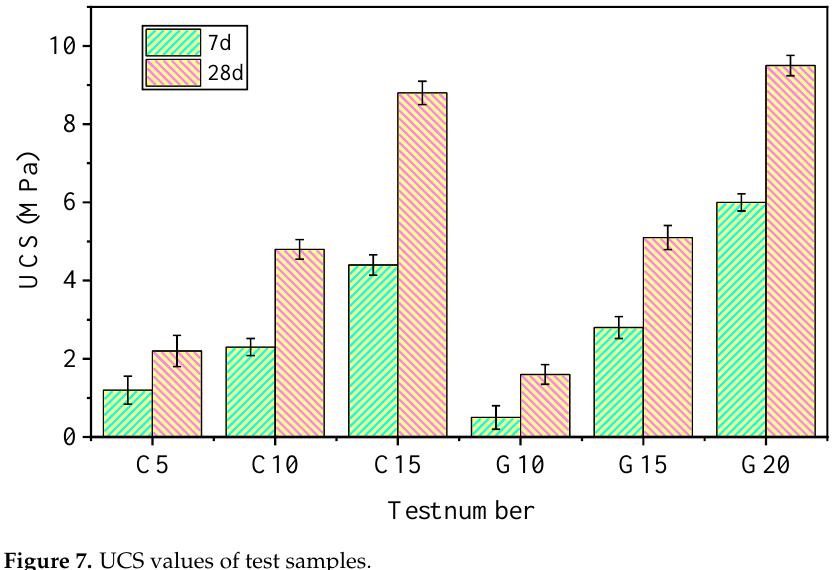
Figure 7. UCS values of test samples.